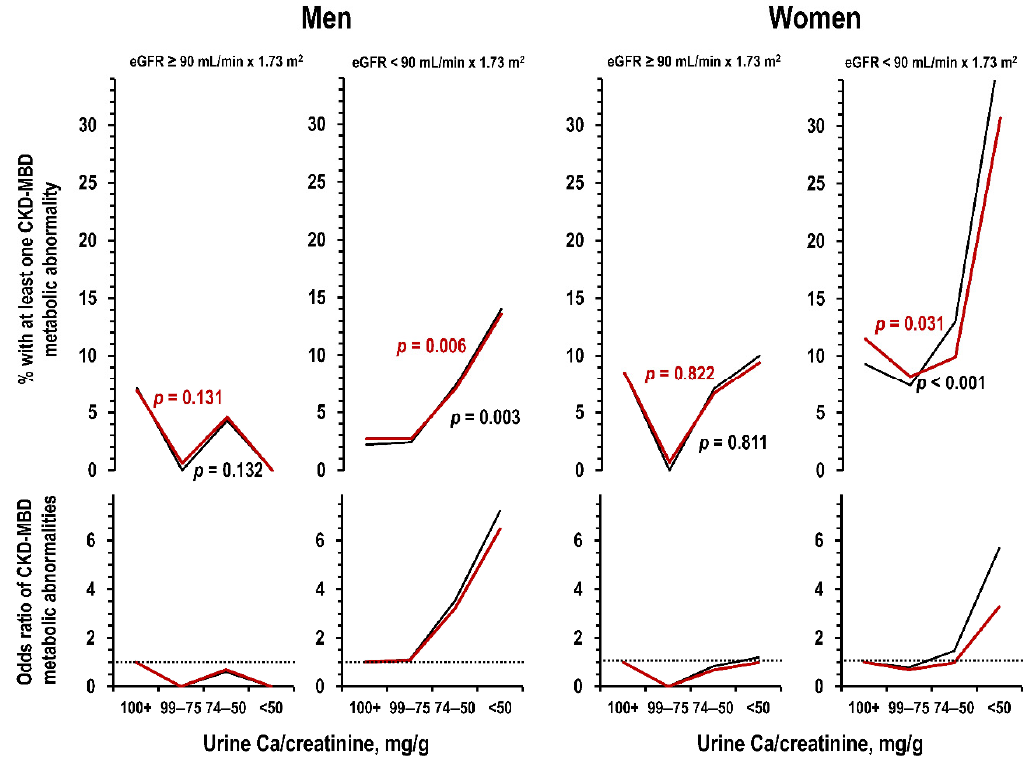
Figure 5. Moli-sani dataset: prevalence ( upper panels) and OR ( lower panels) of individuals with at least one CKD-MBD metabolic abnormality in men and women ( left panels and right panels, respectively) by stratum of urine Ca/creatinine ratio, in the group without reduced kidney function and in the group with reduced kidney function. Reduced kidney function was defined as eGFR < 90 mL/min × 1.73 m 2 . p value are for trend along strata of urine Ca/creatinine ratio in univariate analyses and in analyses controlled for age and weight (black line and red line, respectively). Number of individuals per urine Ca/creatinine stratum from left to right: men = 176, 72, 114, and 126—women = 276, 75, 60, and 56.